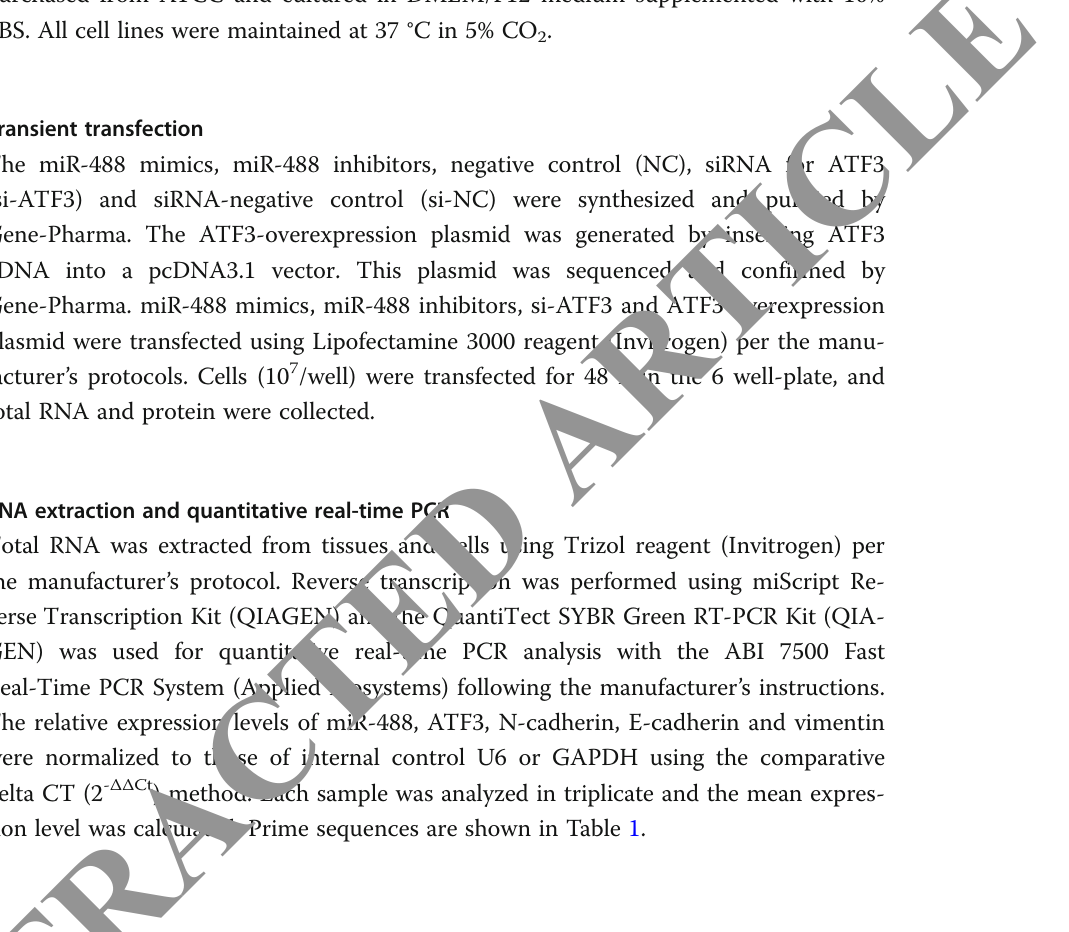
Table 1 Sequence of primers for quantitative RT-PCR